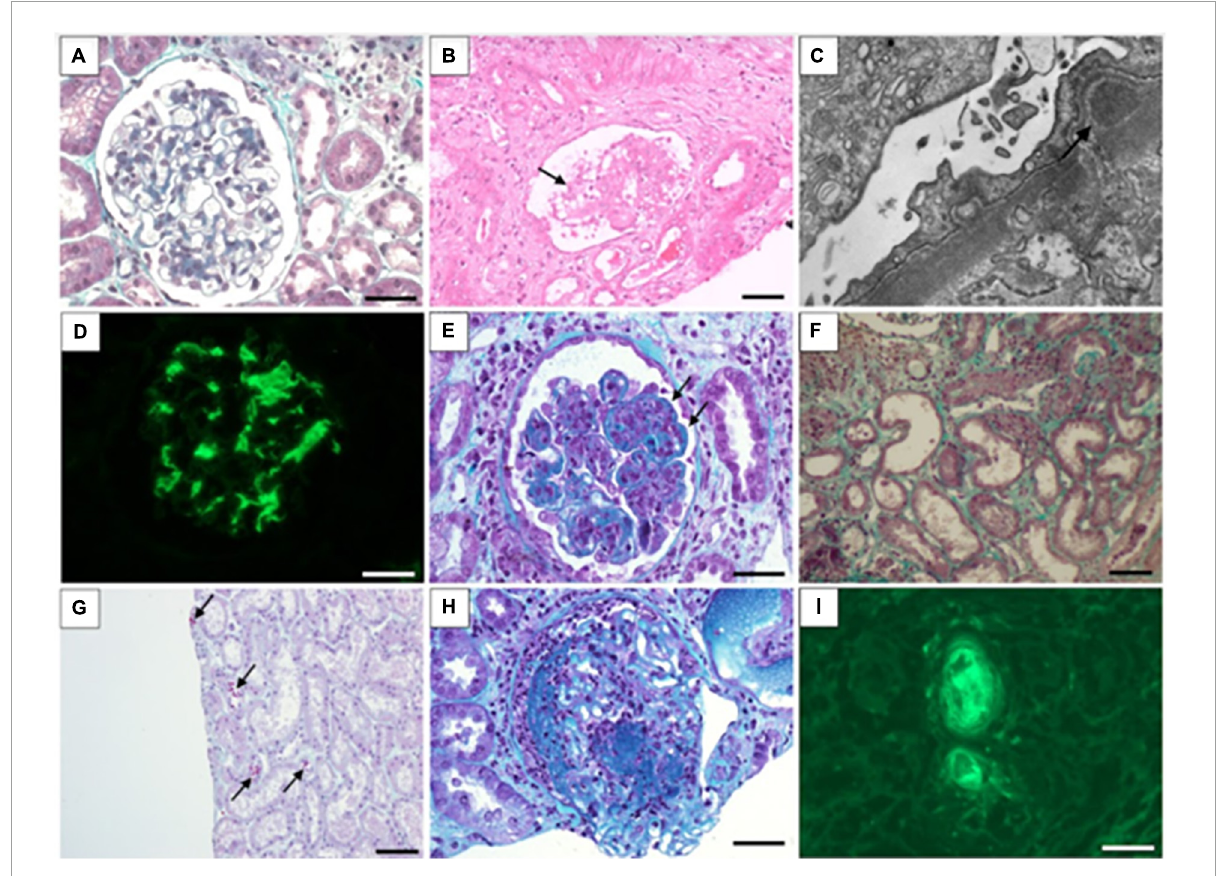
FIGURE1 Morphological findings associated with COVID-19 infection in kidney biopsy. (A) Normal glomerulus in minimal change disease (Masson’s trichrome stain); (B) glomerular collapse and podocytes hyperplasia (arrow) in collapsing glomerulopathy (hematoxylin and eosin stain); (C) Subepithelial deposits in membranous nephropathy (electron microscopy); (D) Intense mesangial IgA deposits in IgA nephropathy (immunofluorescence); (E) Endocapilar proliferation and wire-loop hyaline deposits in class IV lupus nephritis (Masson’s trichrome stain); (F) Flattened tubular epithelial cells in dilated tubules in in acute tubular injury (Masson’s trichrome stain); (G) Ectatic tubules and ducts contain red-orange granular casts caused by rhabdomyolysis (Masson’s trichrome stain); (H) Glomerular necrosis and crescent formation in cases of immune complex-mediated crescentic glomerulonephritis (Masson’s trichrome stain); (I) Fluorescence shows intravascular thrombi in thrombotic microangiopathy (detected with antibody to fibrinogen). (A,D,H,I): Barr = 20 µ m; (B,G,F): Barr = 50 µ